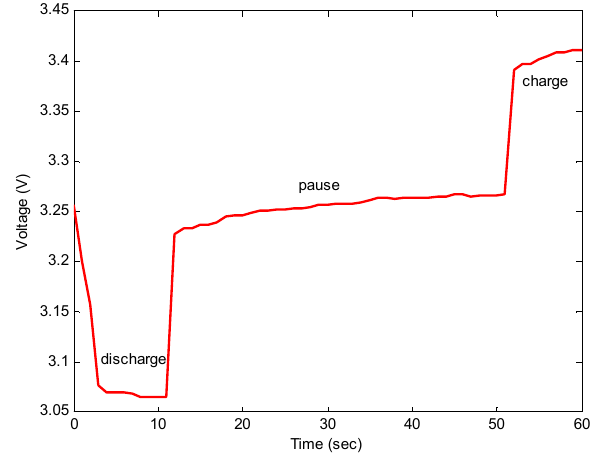
Figure 6. Battery terminal voltage profile in HPPC test at 50%